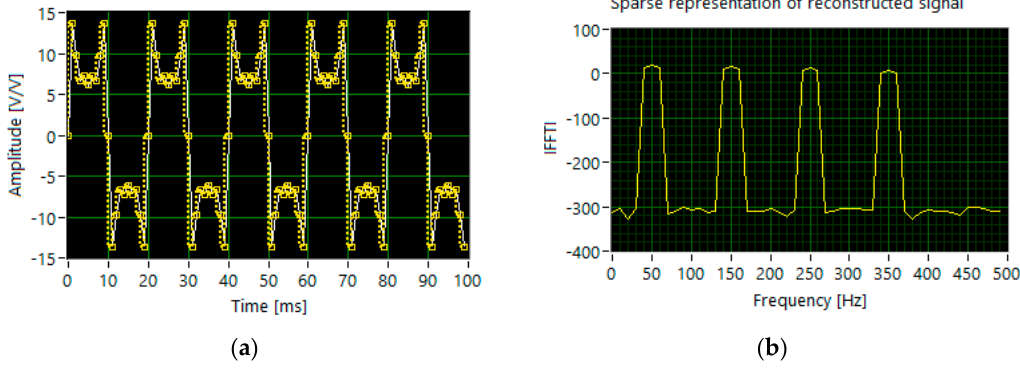
Figure 6. The results of simulation for set 1: ( a ) the segments of time waveforms of the original (white line) and reconstructed signal (dotted yellow line); ( b ) DFT components of the reconstructed signal.